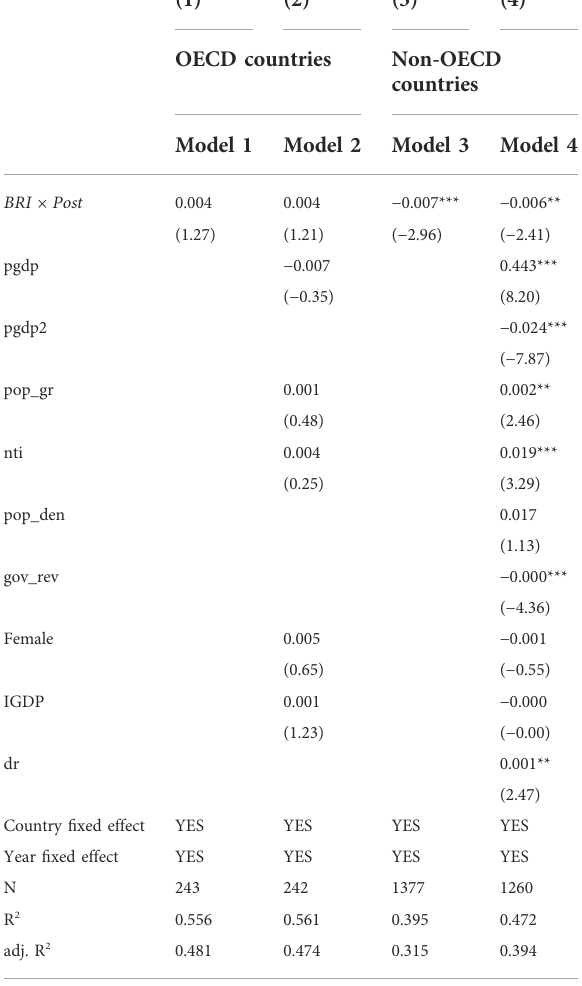
TABLE 13 Effects of the Belt and Road Initiative on environmental quality: OECD or